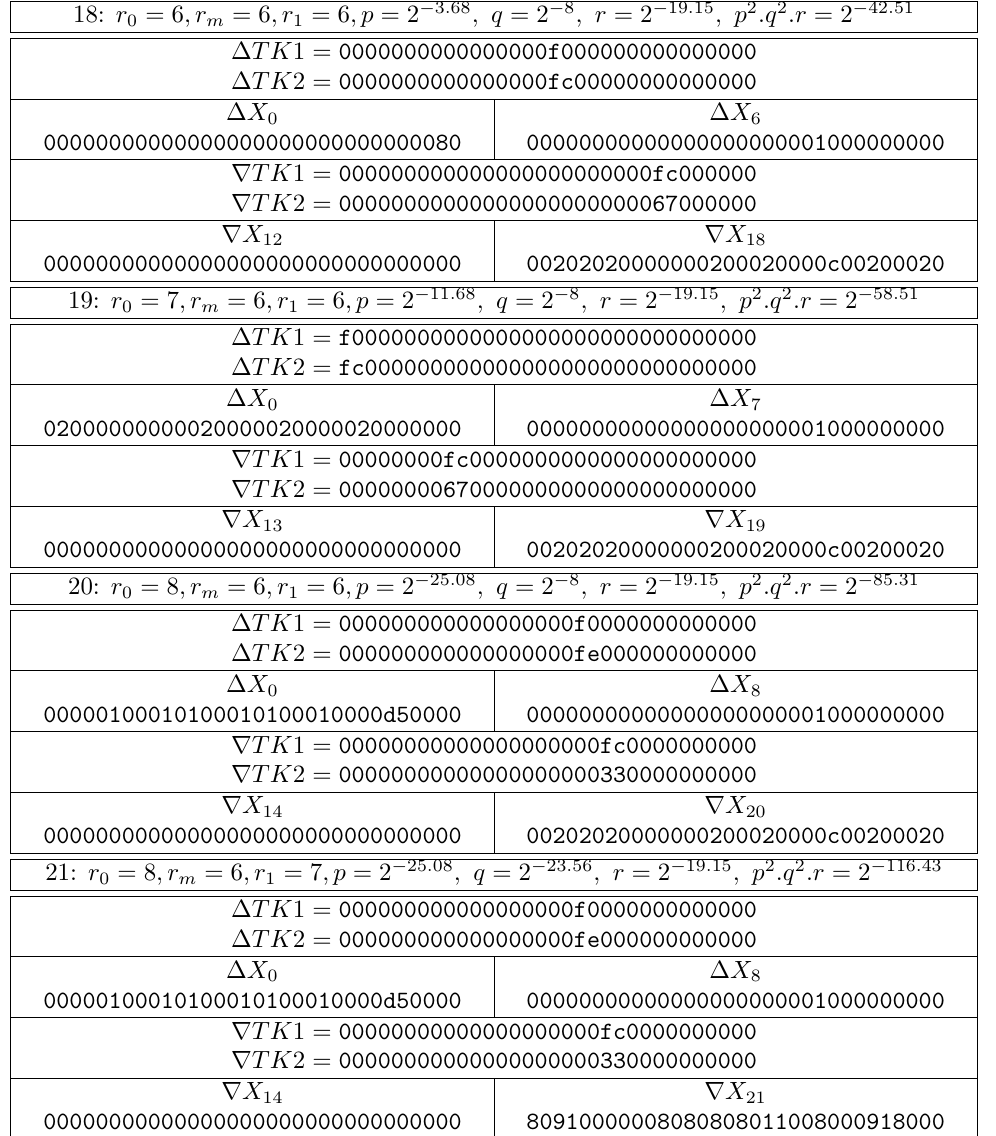
Table 18: Boomerang distinguisher I for 18, 19, 20 and 21 rounds of SKINNY